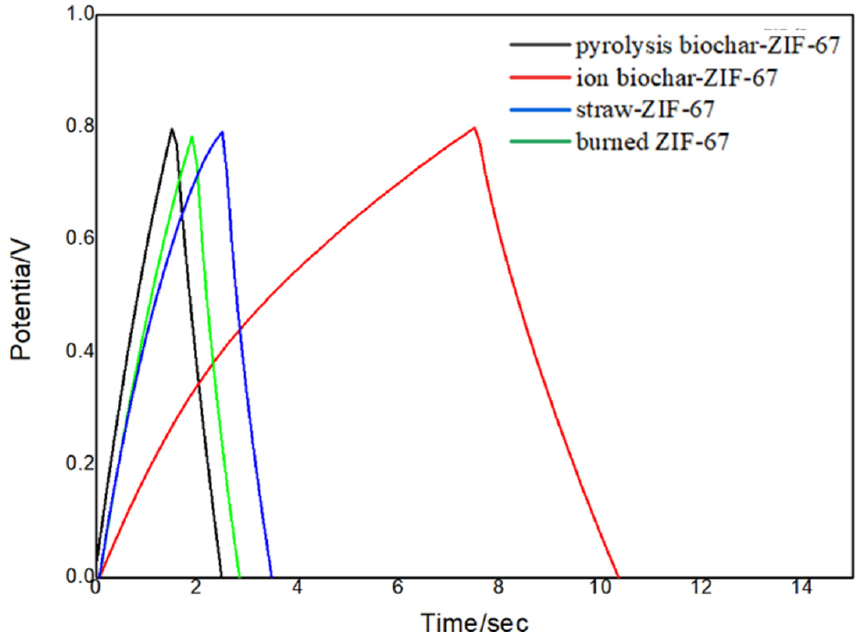
Figure 4. Charge–discharge curves of different materials at 0.01 A/g.